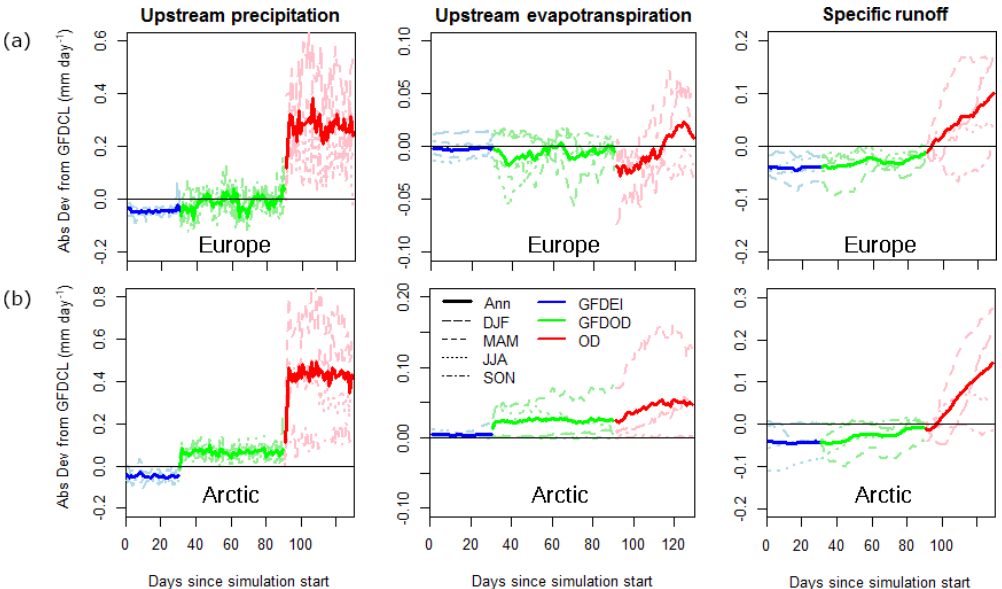
Figure 5. Upstream precipitation, evapotranspiration and specific runoff averaged over all catchments and shown for all forecast times as well as per season for (a) E-HYPE and (b) Arctic-HYPE. All runs are presented as absolute deviations (Abs Dev) from the GFDCL forced simulation.